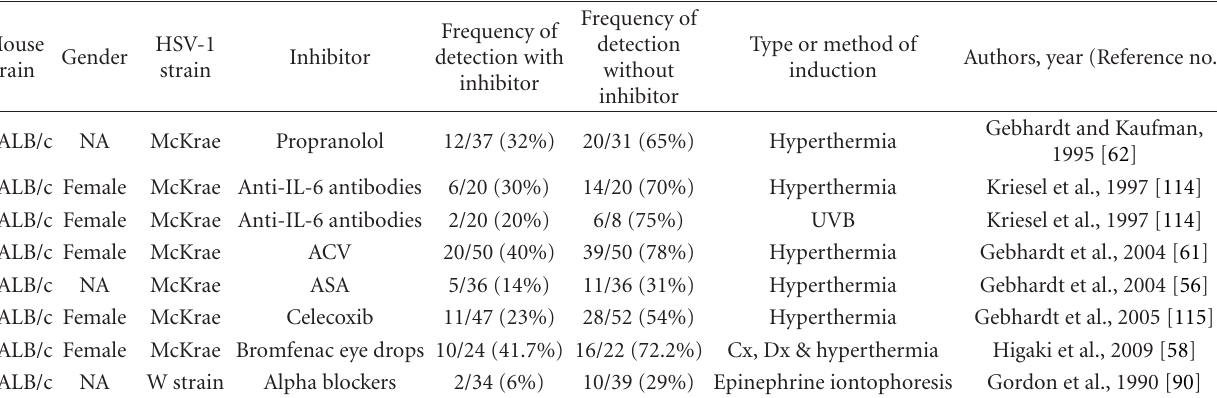
Table 4: Inhibition of induced HSV-1 reactivation in latent mice after